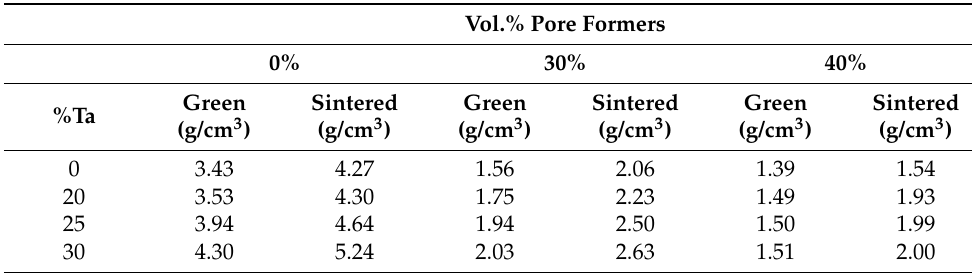
Figure 3. Densification rate as a function of temperature during heating up to 1260 °C of; ( a ) Ti and Ti-xTa; and ( b ) Ti without and with 30 vol.% of pore formers. Table 1. Green and sintered densities of samples with different quantities of Ta with and without additional porosity.